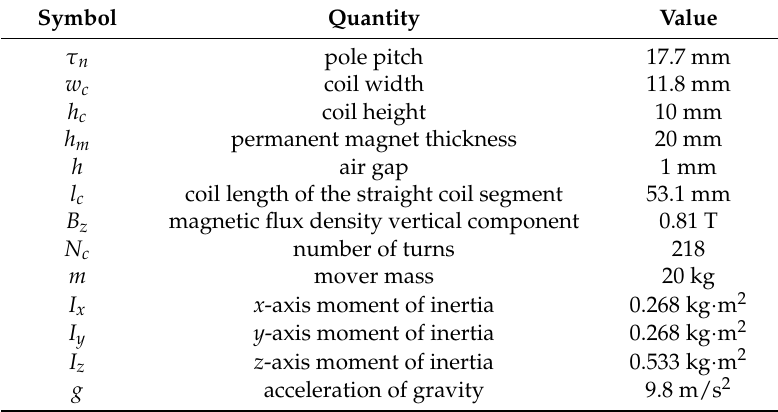
Table 1. Main parameters of the planar motor.